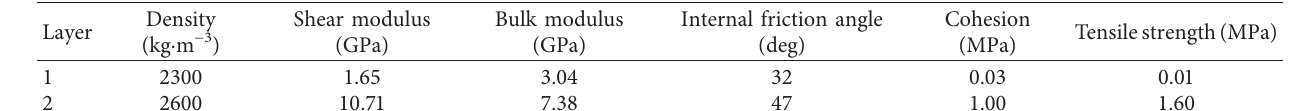
Figure 1: Modeling and monitoring points. Table 1: Physicomechanical parameters of rock masses.